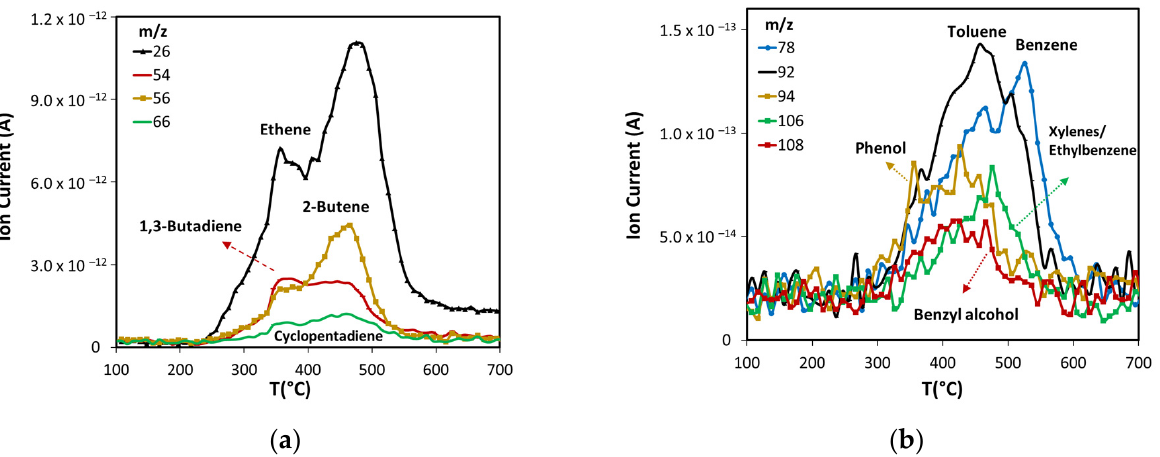
Figure 5. Products formed in non-catalytic pyrolysis of ASB. ( a ) Light olefins, and ( b ) aromatic com- pounds.